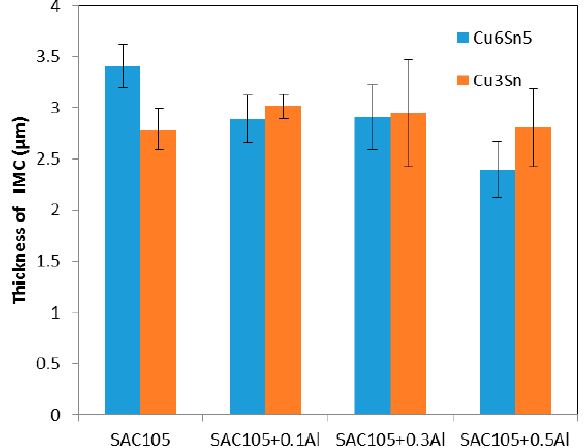
Figure 10. Variation of thickness of IMC with Al content after aging at 150 °C for 720 h.